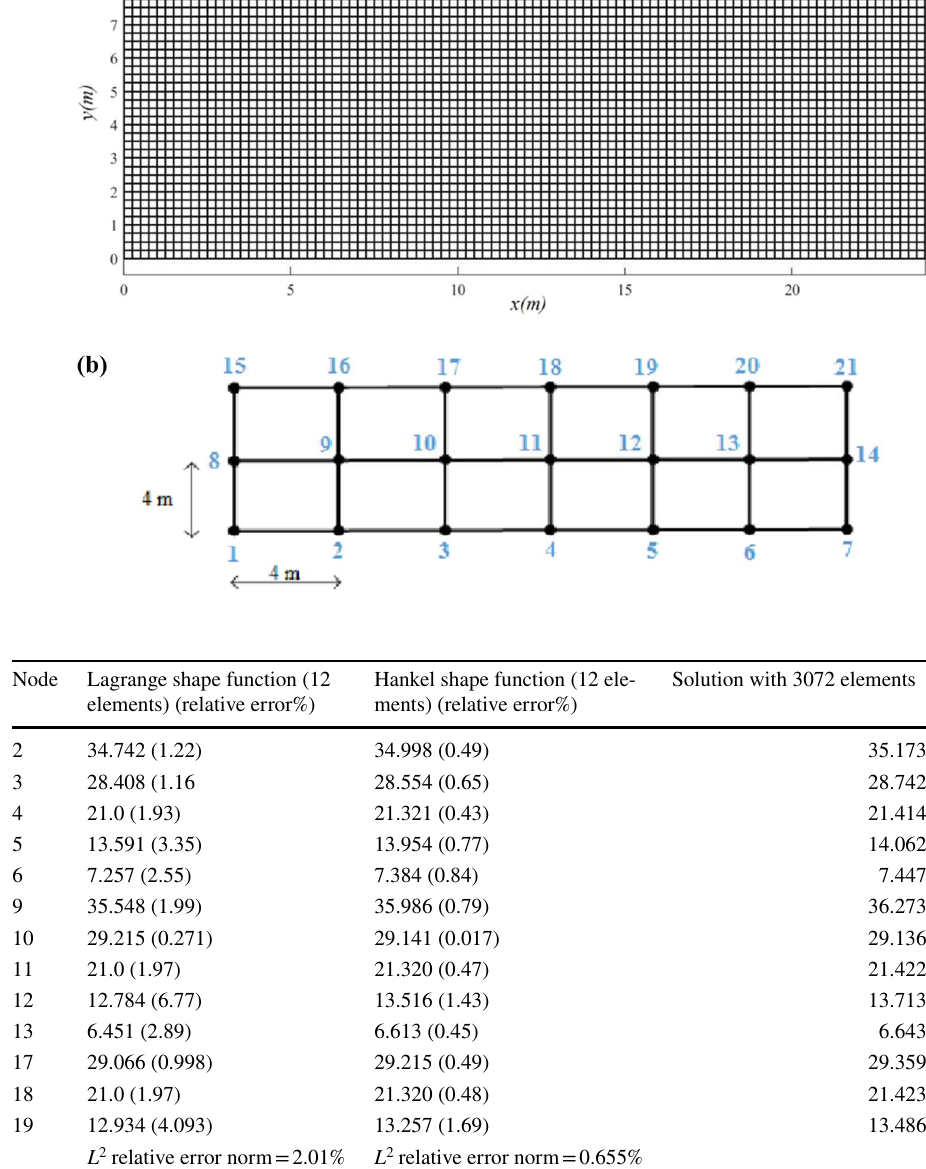
Fig. 8 Meshed domain with a 3072 elements, b 12 elements for the second problem